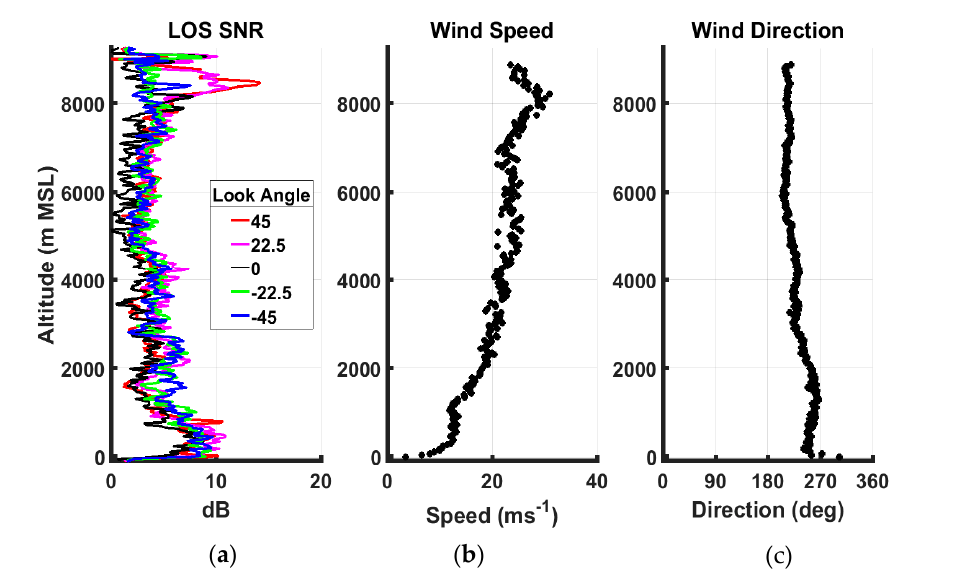
Figure 3. DAWN base vertical profiles of SNR ( a ), wind speed ( b ), and wind direction ( c ) on 6 June 2017 204054Z.